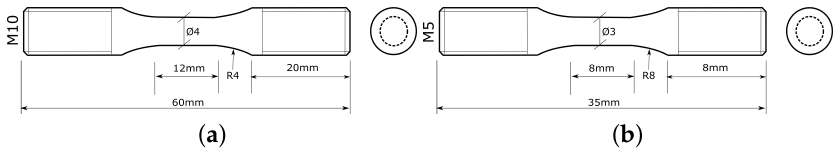
Figure 3. Schematic representation of the axisymmetric samples. Quasi-static and 500 s − 1 dynamic tests were performed with the sample on the left ( a ) and the 150 s − 1 dynamic tests with the sample depicted in ( b )